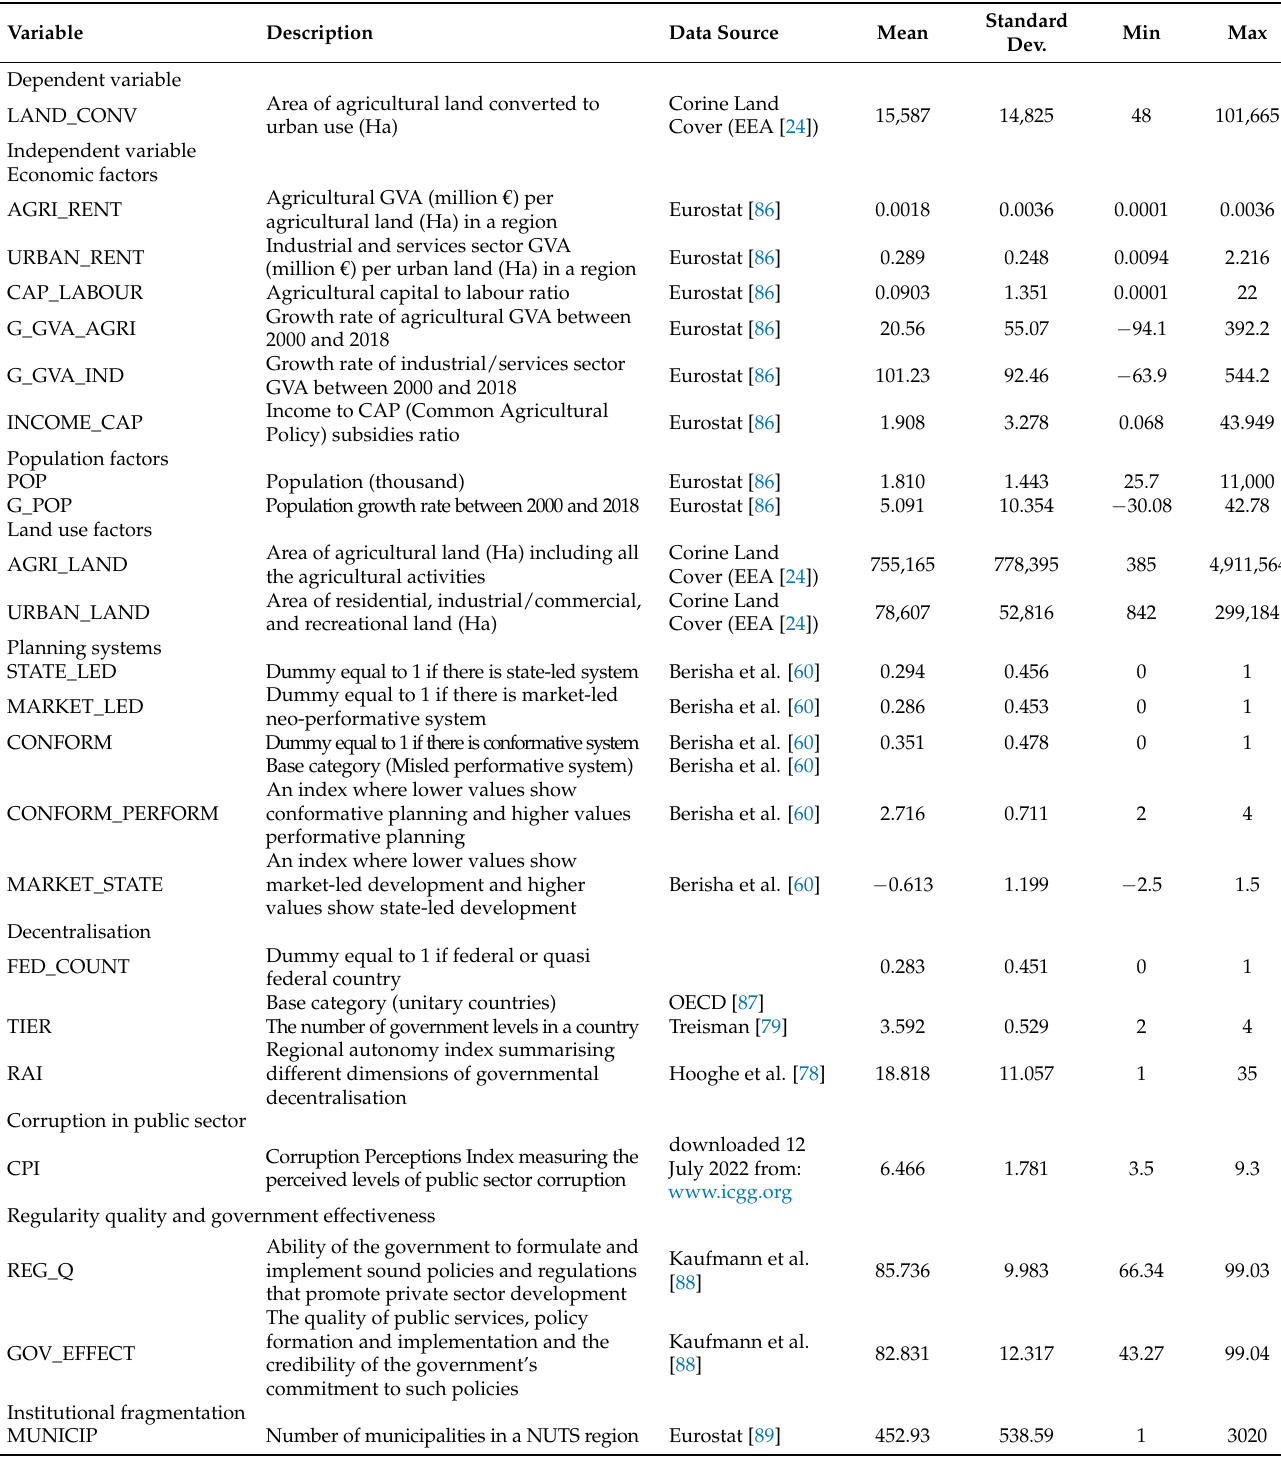
Table 1. Summary of the